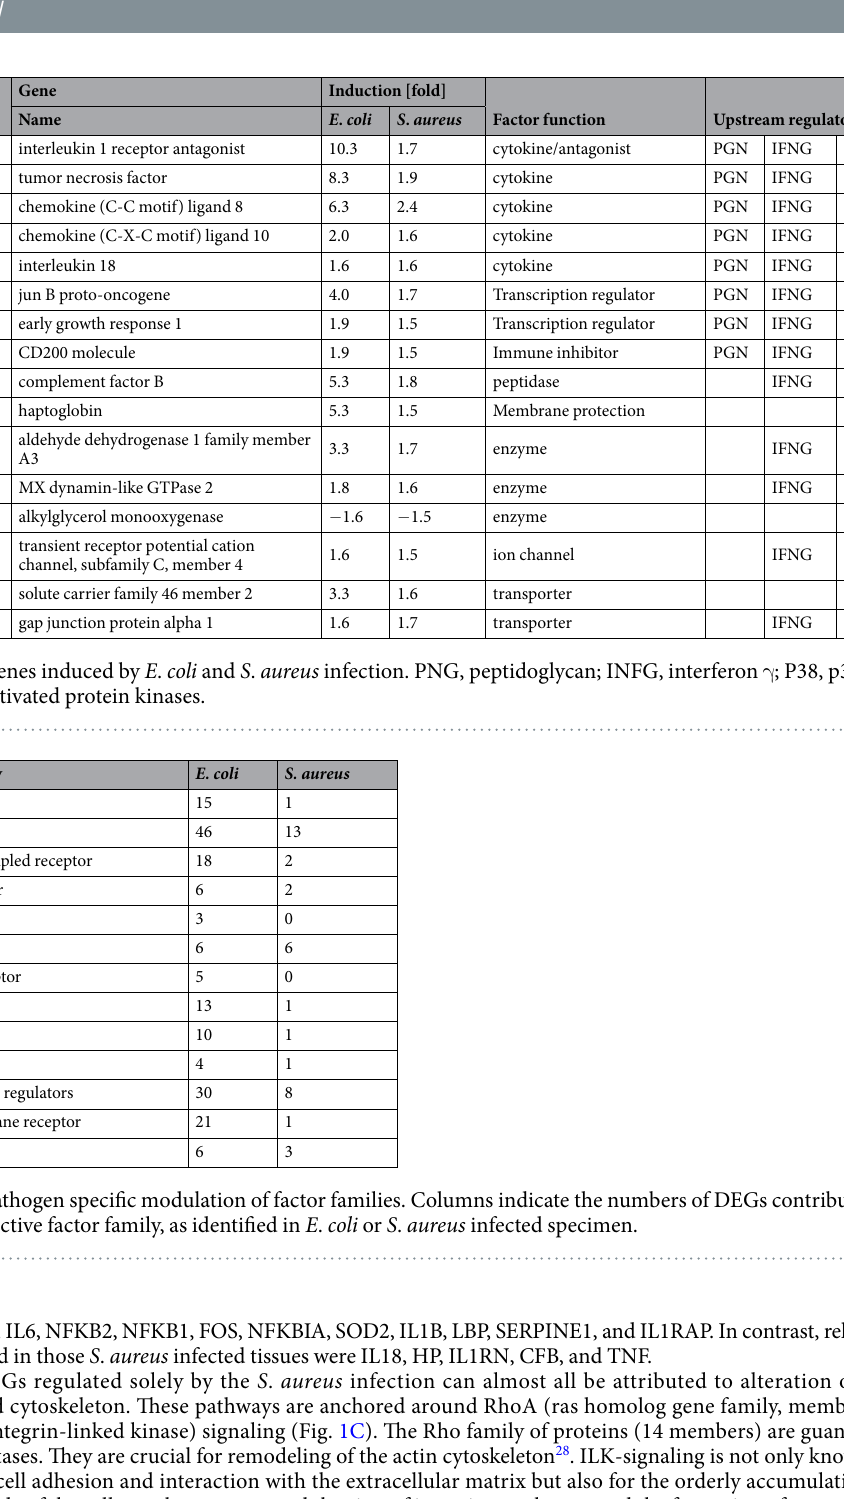
and ILK (integrin-linked kinase) signaling (Fig. 1C). The Rho family of proteins (14 members) are guanosine triphosphatases. They are crucial for remodeling of the actin cytoskeleton 28 . ILK-signaling is not only known to mediating cell adhesion and interaction with the extracellular matrix but also for the orderly accumulation of F-actin inside of the cell membrane at around the sites of integrin attachment and the formation of stress fibers and focal adhesion 29 . Indeed, 33 from among the 98 DEGs (e.g. 33.7%) regulated only through the S . aureus infection were factors related to cytoskeletal structures or their regulators (Supplementary Table 3). In contrast, E . coli infection modulated only the expression of ACTC1 (actin, alpha, cardiac muscle 1) from among all of the cytoskeleton related factors.